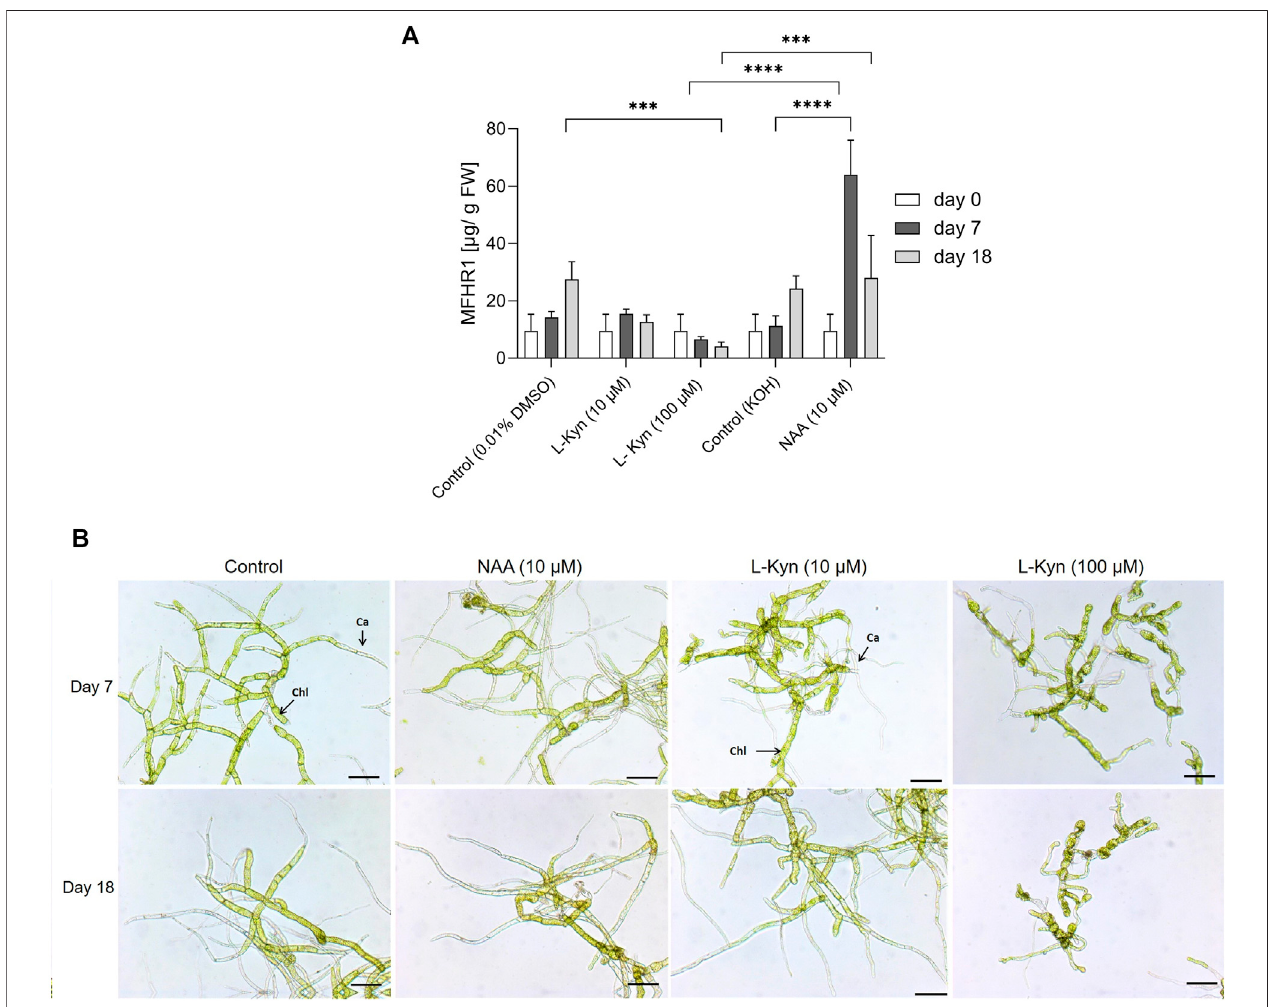
FIGURE 3 | Exogenous auxin (NAA) enhanced recombinant protein production in Physcomitrella at shaken- fl ask scale, using transgenic moss line A. (A) Effect of exogenous auxin (NAA) and auxin biosynthesis inhibitor (L-Kyn) on MFHR1 production in Physcomitrella. NAA (10 µM) signi fi cantly enhanced recombinant protein speci fi c productivity ( p < 0.0001 Two-way ANOVA, Tukey Post-hoc) compared with the control without NAA, while L-Kyn inhibited protein speci fi c productivity signi fi cantlycomparedwiththecontrol( p =0.0009,Two-wayANOVA,TukeyPost-hoc)andNAAtreatment( p =0.0007,Two-wayANOVA,TukeyPost-hoc)atday 18. Data represent mean ± standard deviations (SD) from three biological replicates (B) Representative light microscopic images of protonema tissue under different conditions growing in suspension in shaken fl asks with NAA, L-Kyn and a control in standard medium Knop ME. Scale bar: 100 µm.